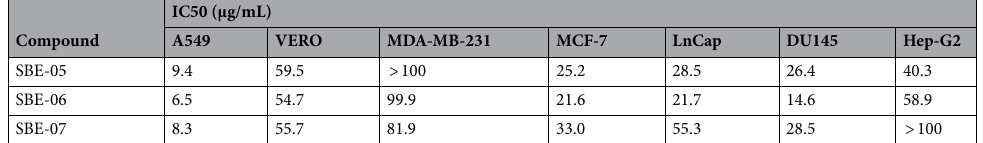
Table 2. IC 50 (ug/mL) of SBE-05, SBE-06 and SBE-07 against A549, MCF-7, MDA-MB-231, Hep-G2, LnCaP, DU145 and VERO cells extracted from the dose response curves. SBE Sorghum Bicolor extract, IC 50 Half maximal inhibitory concentration, A549 Lung adenocarcinoma, VERO African green monkey normal kidney epithelial cell, MDA-MB-231 Triple negative breast adenocarcinoma cell lines, MCF-7 ER ( +) breast adenocarcinoma cell lines, LnCap AR ( +) prostate cancer cell lines, DU145 AR (-) prostate cancer cell lines, Hep-G2 Hepatocellular carcinoma cell lines.